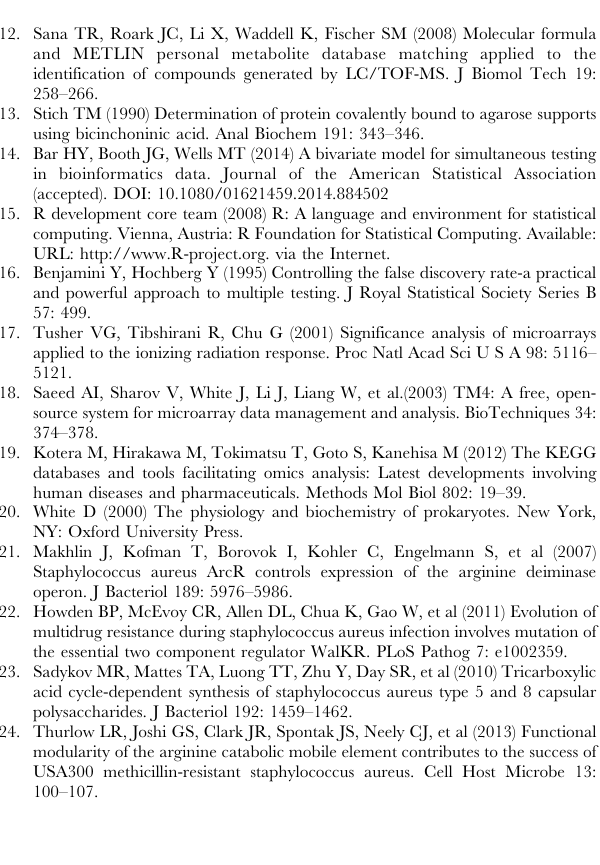
Table S4 Characteristics and ‘‘raw’’ (biomass-adjusted and normalized to baseline) ion counts of the 72 identified metabolites for isolates JH1 and JH2. Super- script ( a ) denotes Retention Time (RT), ( b ) denotes Positive Mode (POS) versus Negative Mode (NEG), ( c ) denotes Molecular Feature Extraction (MFE), which extracts chromatographic peaks by molecular features versus Find by Formula (FBF) which extracts peaks by chemical